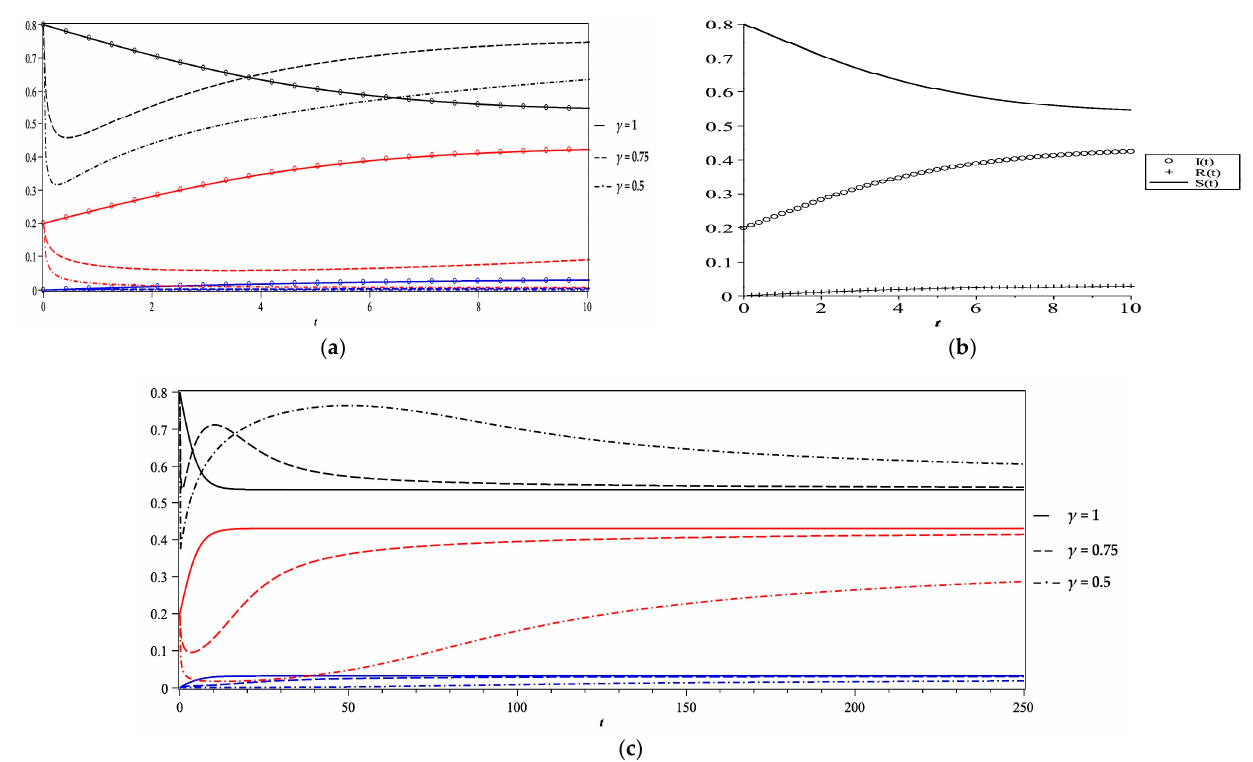
Figure 5. Behavior of various individual fractions ( S in black , I in red and R in blue) versus time for Case 4 at different fractional order values ( a ) till T = 10, ( b ) results of [3] and ( c ) till T = 250. Table 1. Impact of various parameter values on the population